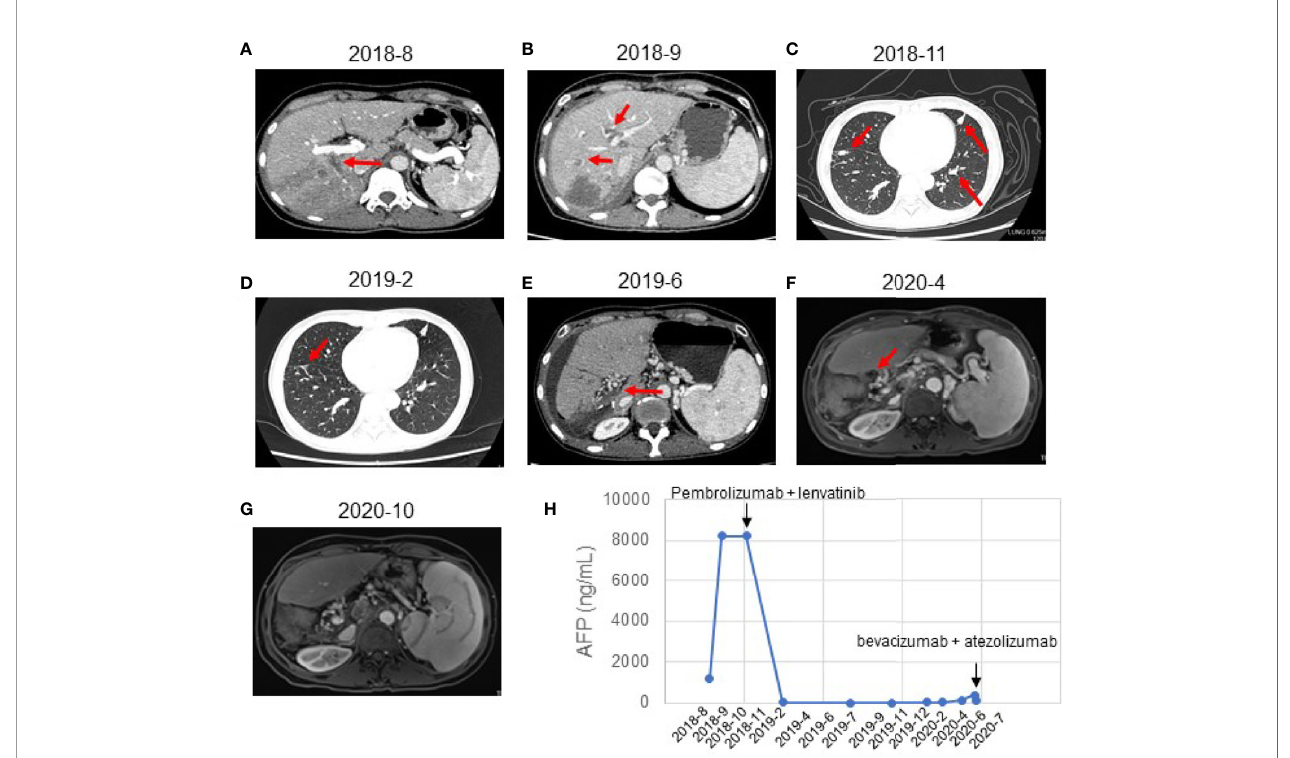
FIGURE 1 | Response evaluation during the clinical course including changes in imaging and quantitative data. (A) Preoperative abdominal-enhanced CT revealed a mass in the right posterior lobe of the liver (August 21, 2018). (B) CT showed multiple nodules in the liver and tumor thrombus in the right hepatic vein and the left portal vein (September 21, 2018). (C) CT indicated new nodules in the lower lobe of the right lung and the upper lobe of the left lung. The multiple original nodules in the lungs had grown (November 2, 2018). (D) CT indicated a complete response to pembrolizumab plus lenvatinib (February 2019). The pulmonary nodules had disappeared after treatment. (E) CT showed postoperative changes of liver cancer, abnormal density in the liver margin, and a few new in fl ammatory lesions in both lungs 4 months after treatment with pembrolizumab and lenvatinib (June 2019). (F) MRI showed no local active foci and multiple lymph nodes of different sizes in the hilar area and retroperitoneum (April 2020). (G) MRI showed a complete response to atezolizumab and bevacizumab (October 2020). The retroperitoneal lymph nodes had disappeared after treatment. (H) Graphical depiction of the change in alpha-fetoprotein (AFP) over